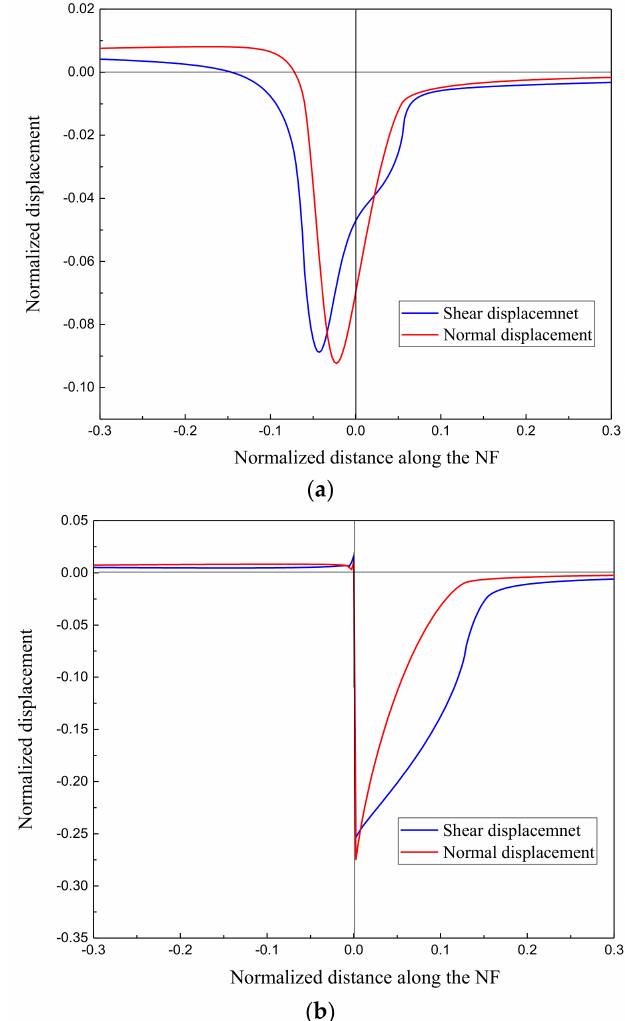
Figure 9. Normalized displacement distribution along the natural fracture (NF). ( a ) Fractures gap ρ = 0.1 m; ( b ) Fractures gap ρ = 0